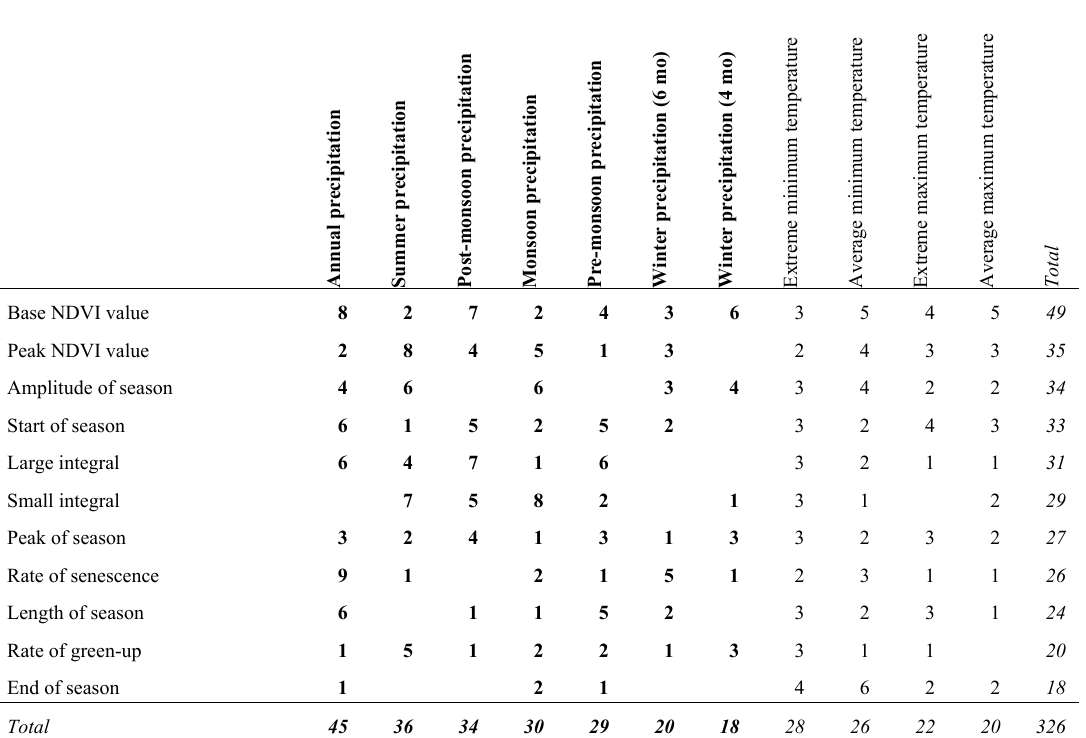
Appendix B : Overview and ranking (left to right and top to bottom) based on the total number of significant (p ≤ 0.05) relationships between phenometrics and climate metrics among all vegetation types. The precipitation (in bold) and temperature metrics were ranked